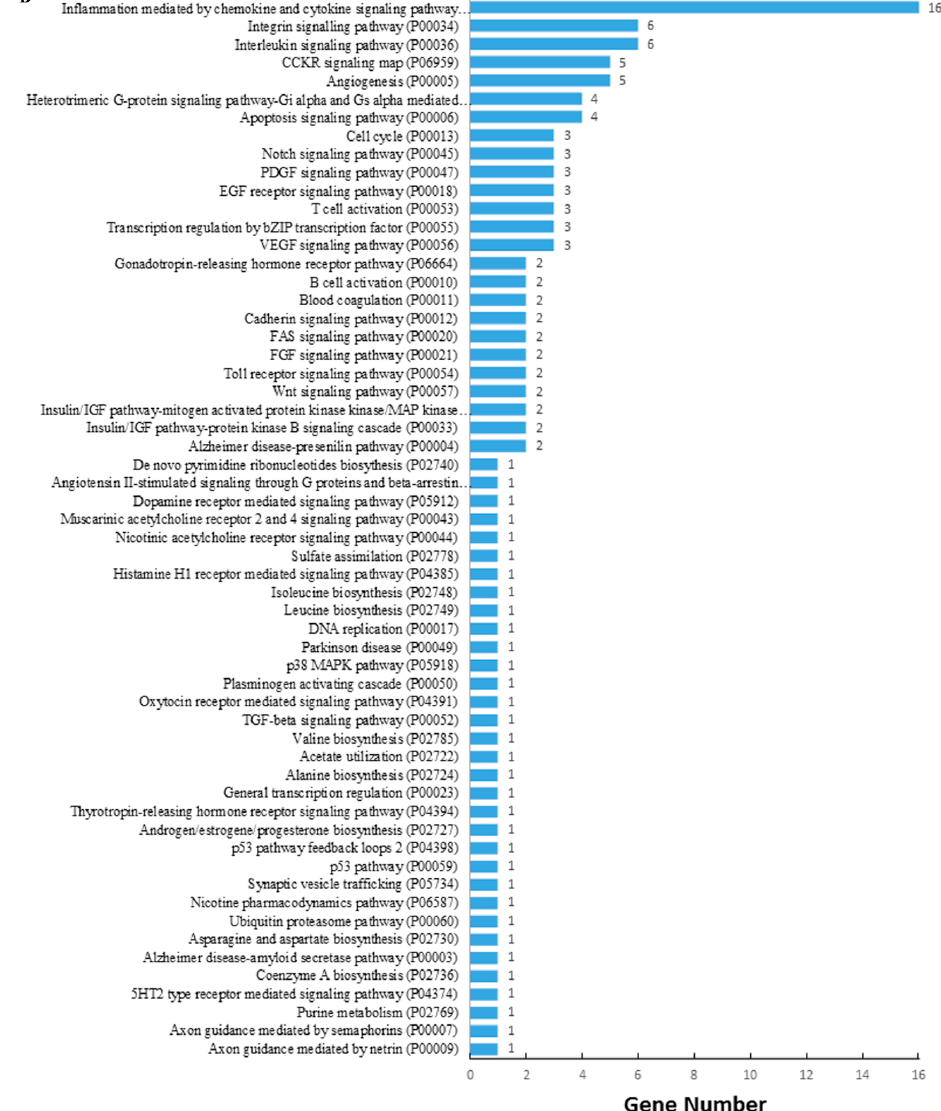
Figure 4. KEGG analysis of the predicted targets of differentially expressed mRNAs and miRNAs between fresh and frozen ‐ thawed boar sperm: ( A ) mRNAs. The vertical coordinate represents KEGG pathway, and horizontal coordinate represents the number of genes annotated to the pathway and accounts for the proportion of the total number of genes that were annotated; ( B ) predicted targets of differentially expressed miRNAs. The vertical coordinate represents KEGG pathway, and horizontal coordinate represents the number of genes annotated to the